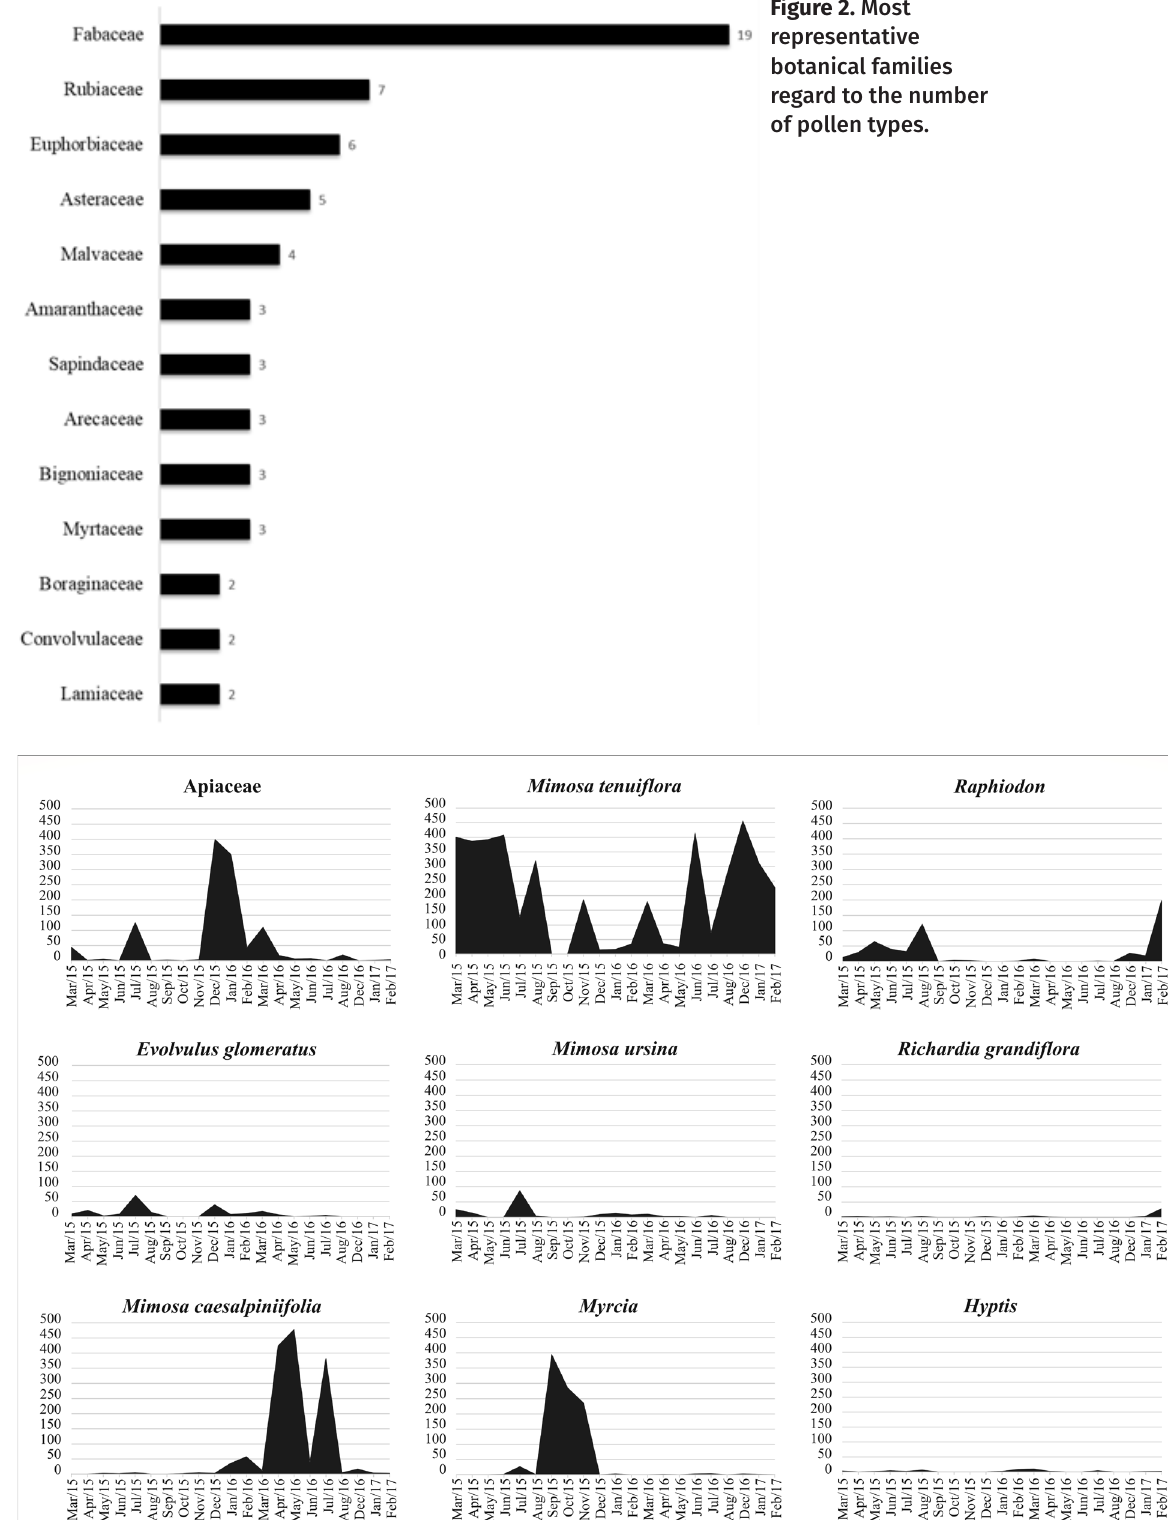
Figure 3. The frequency of pollen types with higher occurrence in the honey samples (>